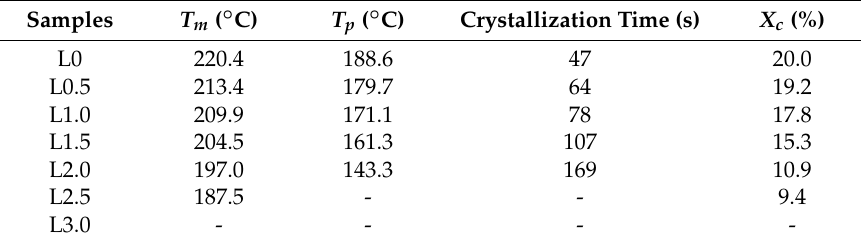
Figure 1. Differential Scanning Calorimetry (DSC) thermograms of composites with different LiCl contents: ( a ) melting curve; and ( b ) crystallization curve. Table 2. DSC analysis data of composites with different LiCl contents.